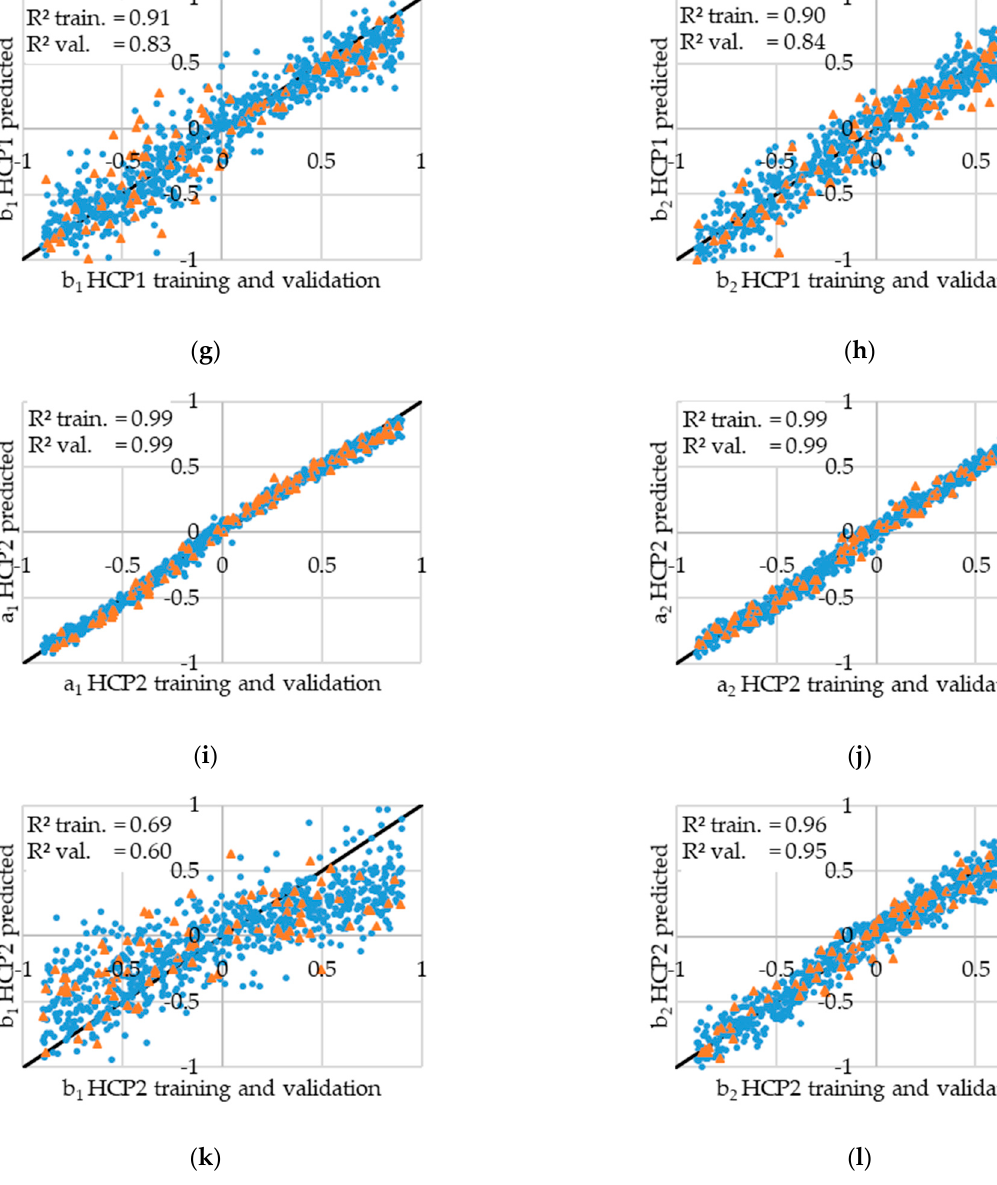
Figure 5. Predicted parameter values over training and validation data of all components. Training data are shown as blue dots. Validation data are shown as orange triangles. The black line represents the bisecting line. Every point, which lies directly on the bisecting line, is a perfect prediction. The coefficient of determination (R 2 ) of training (R 2 train.), and validation ( R 2 val.) set, are shown in the upper left corner of each panel. The prediction results of a 1 , a 2 , b 1 , and b 2 are shown in order for IgG in ( a – d ), for HCP1 in ( e – h ) and for HCP2 in ( i – l